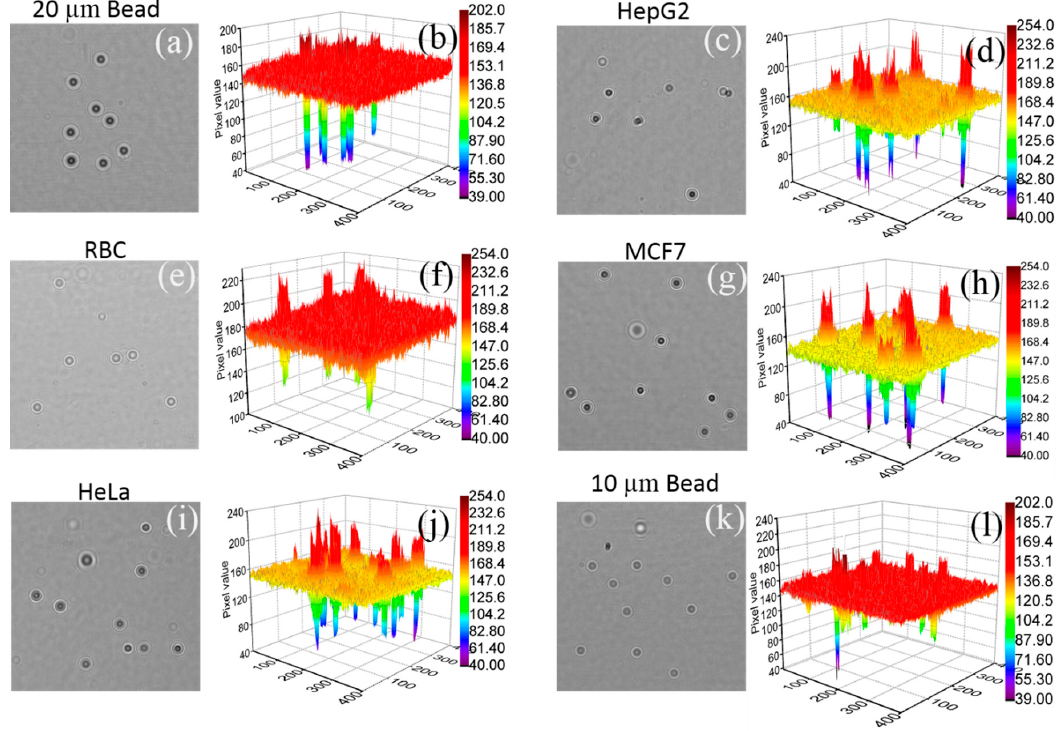
Figure 4. 3D intensity plot of lens-free images of six samples. ( a ) 20 μ m bead; ( c ) HepG2; ( e ) RBC; ( g ) MCF7; ( i ) HeLa cell; and ( k ) 10 μ m bead. ( b ), ( d ), ( f ), ( h ), ( j ), and ( l ) are the 3D intensity plots corresponding to ( a ), ( c ), ( e ), ( g ), ( i ), and ( k ),